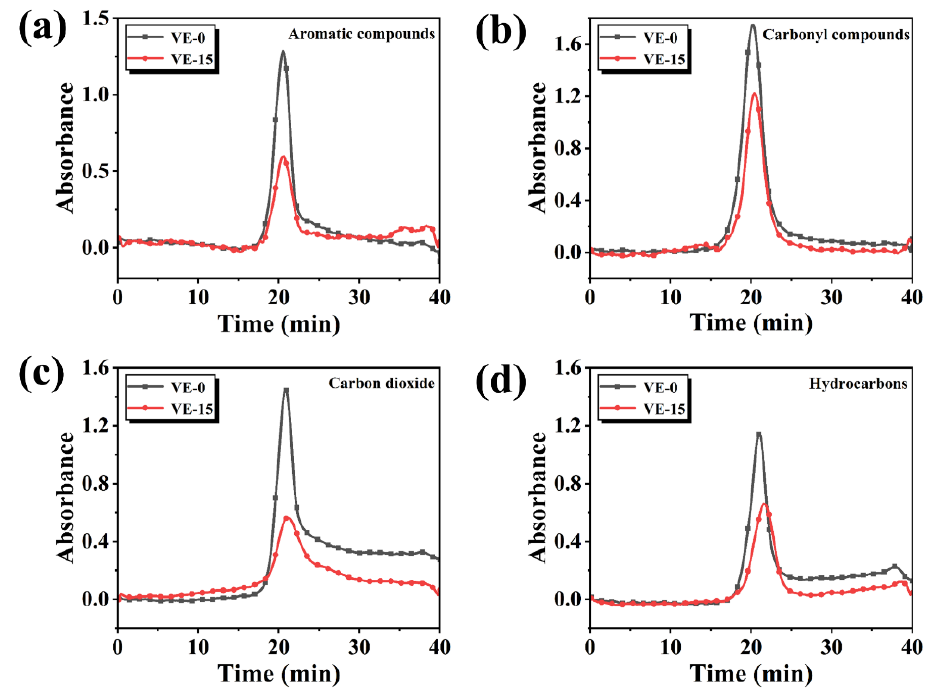
Figure 10. Absorbance intensities of typical pyrolysis products for VE-0 and VE-15: ( a ) Aromatic compounds, ( b ) Carbonyl compounds, ( c ) Carbon dioxide, ( d ) Hydrocarbons. compounds, ( b ) Carbonyl compounds, ( c ) Carbon dioxide, ( d )